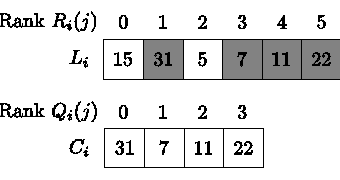
Figure 1. Example of satisfaction computation for node i with b